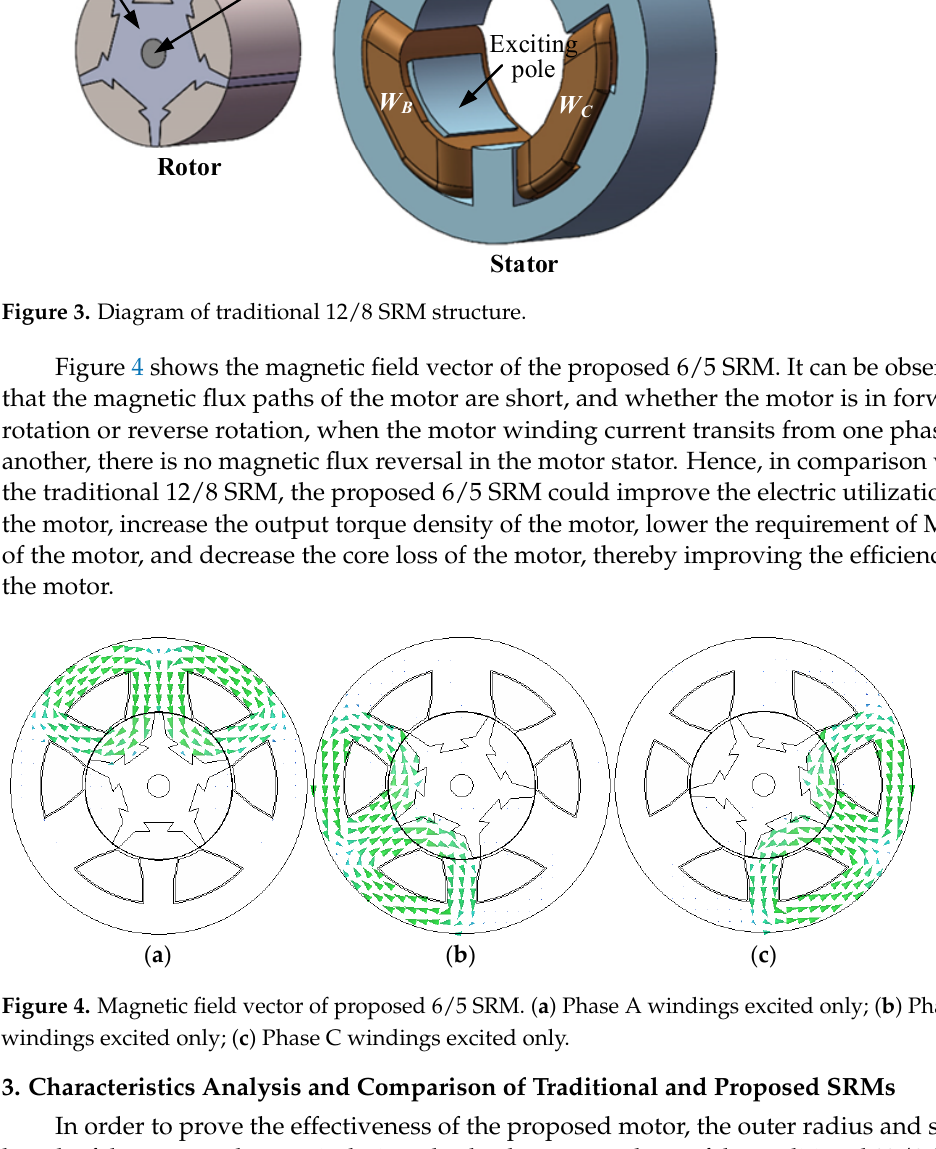
Table 1. Dimensions of traditional and proposed SRMs.